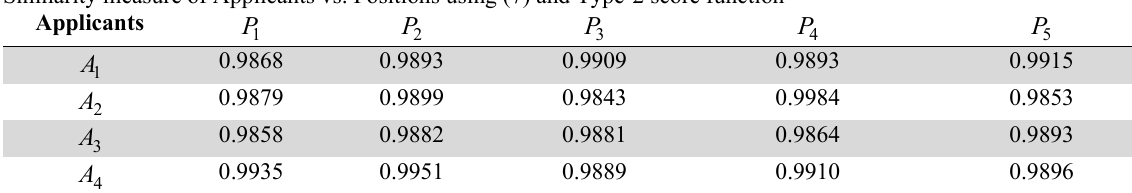
Similarity measure of Applicants vs. Positions using (7) and Type-2 score function